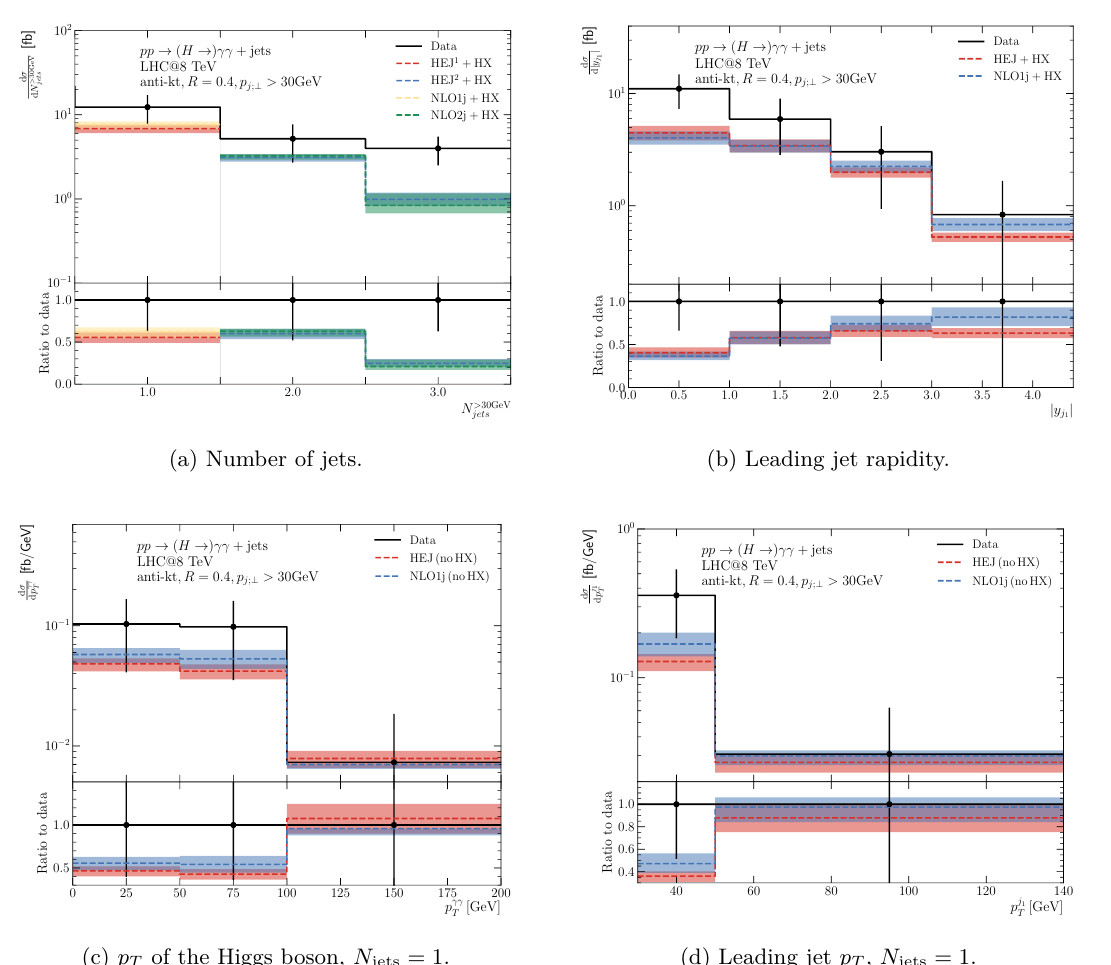
Figure 8. (a): number of jets (exclusive). (b): leading jet rapidity. (c): Higgs boson transverse momentum in the 1-jet bin. (d): leading jet transverse momentum in the 1-jet bin. The 1-jet HEJ predictions are rescaled by the inclusive cross section ratio σ NLO1J /σ of the 2 and 3-jet bins of (a) are rescaled by σ NLO2J /σ is extracted from [33]; this was not available for (c) and